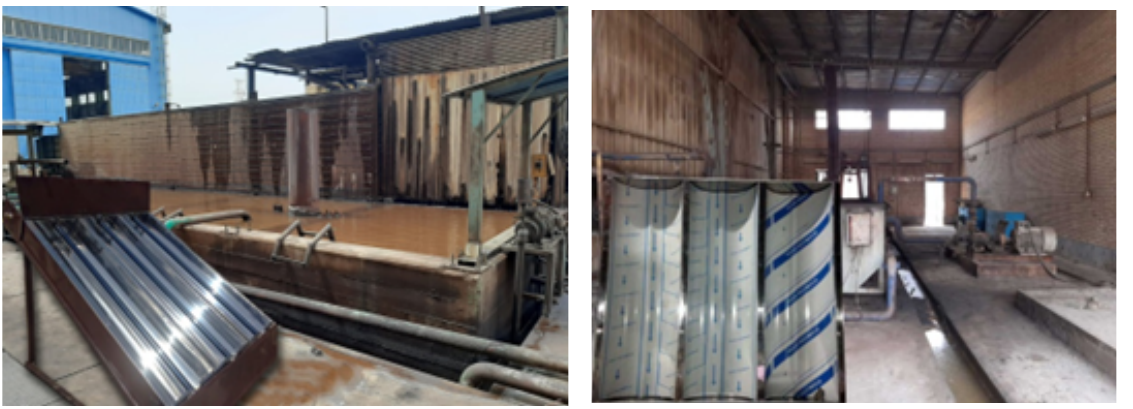
Figure 2: Solar hot water production system of hot water production system with weather conditions of Ahvaz..